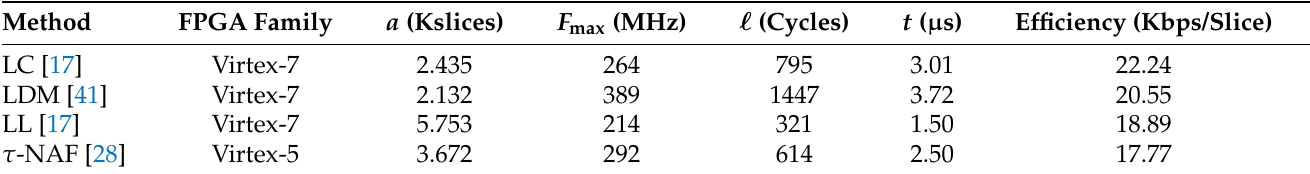
Table 11. Field-Programmable Gate Array (FPGA)-based implementations for F 2 163 . Method